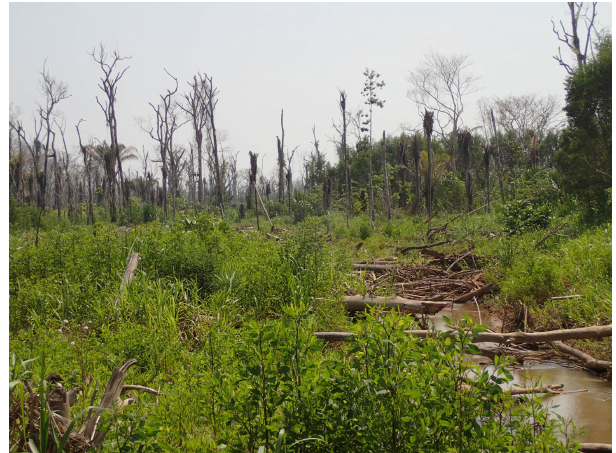
Figure 11. Forest die-off due to the 2016 flood of the Colorado River rapidly being replaced by Echinochloa polystachya and Tes- saria integrifolia .